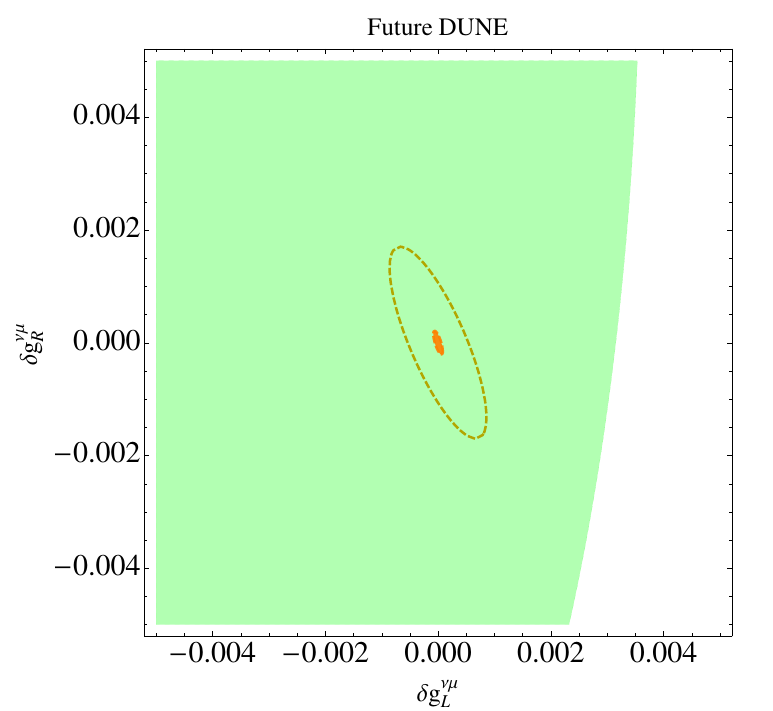
Figure 2 . Orange: projected 95% CL constraints on the wEFT parameters (cid:14)g (cid:23) (cid:22) eq. (2.1) from neutrino scattering o(cid:11) argon nuclei in DUNE ND, assuming the measurement errors will be dominated by statistics. The dashed line shows the analogous constraints assuming 0.1% systematic error on the R i measurements. The green region is allowed by the past (cid:23) - N scattering (cid:23) (cid:22) N experiments